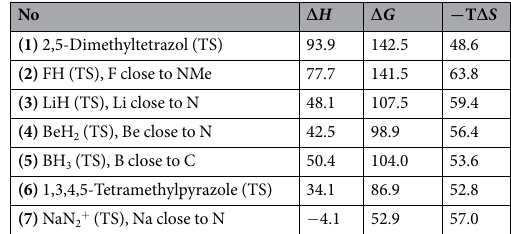
Table 2. Lowest barriers (kJ·mol − 1 ) of the set of 1,3-dipolar cycloadditions. Calculations were carried out at the G4MP2 level of theory for T = 298.15 K. See also Fig. 3.